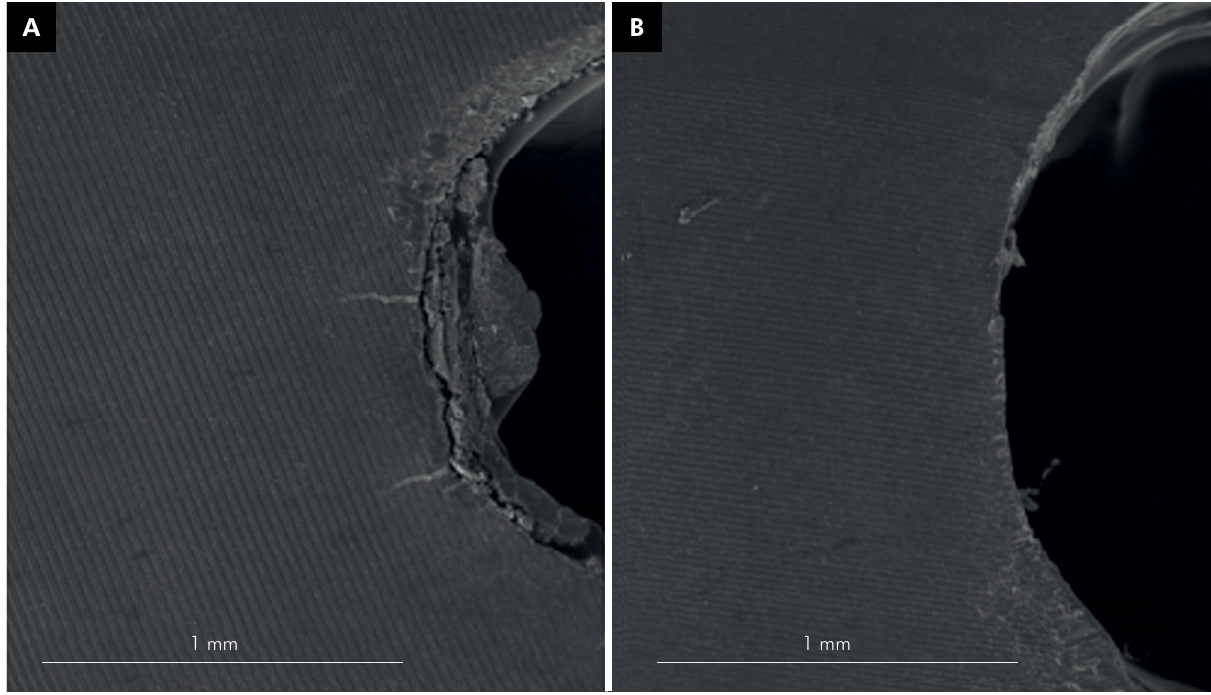
Figure 1. Scanning electron microscopy images of the tooth slices used in the study (magnification 95X). A) With the predentin layer. B) Without the predentin layer.